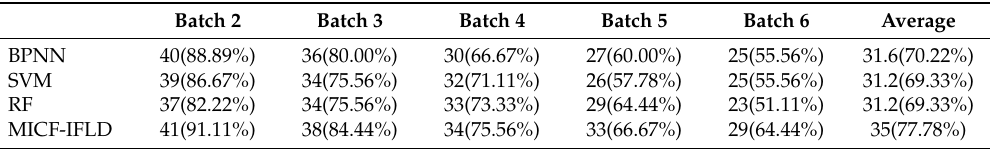
Table 5. Accuracy of classification obtained by BPNN, SVM, RF, and MICF-IFLD (number of correctly classified samples and accuracy).